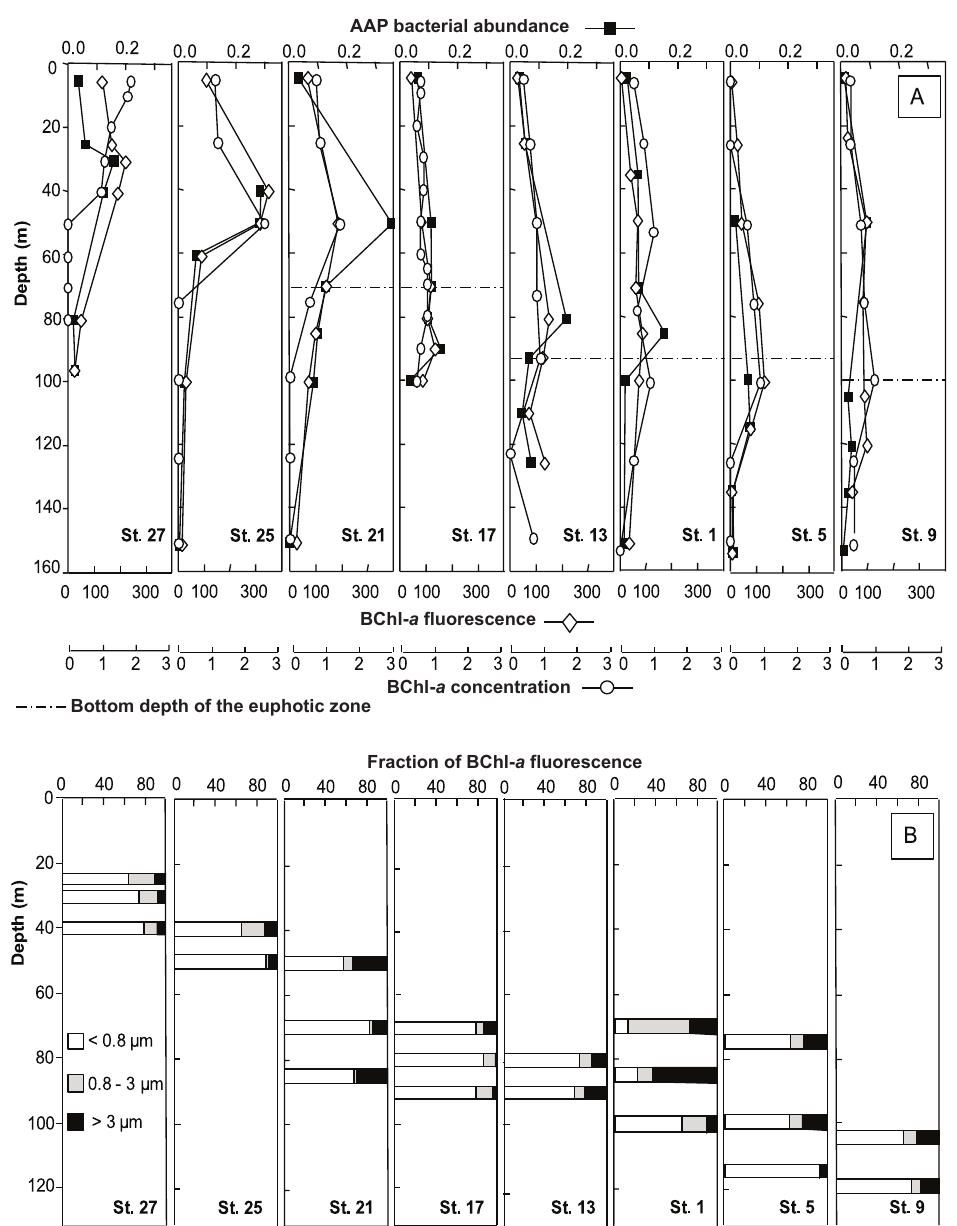
Fig. 3. Vertical profiles at 8 stations along the BOUM transect of (A) AAP bacterial abundance (10 5 cellsml − 1 ) , BChl- a concentration (ngl − 1 ) and BChl- a fluorescence (arbitrary units) and (B) size fractionation ( < 0.8µm, 0.8–3µm and > 3µm) of BChl- a fluorescence (in %). The bottom of the euphotic zone is the depth to which 1% of photosynthetically active radiation (PAR) reached. No PAR data were available at stations 25 and